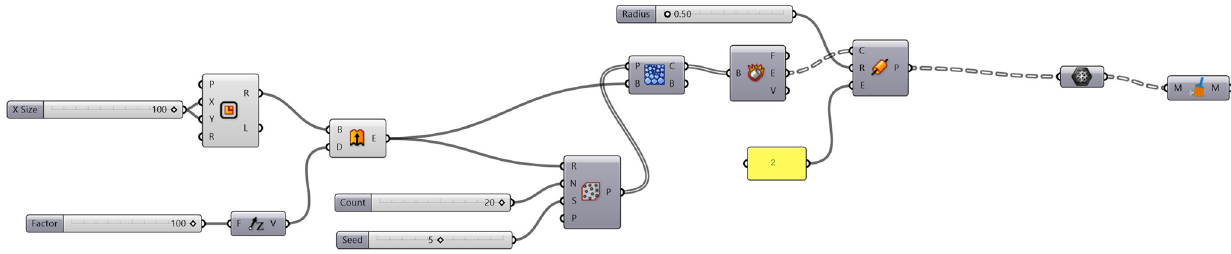
Figure 8. Lorimerlite Grasshopper Workflow.